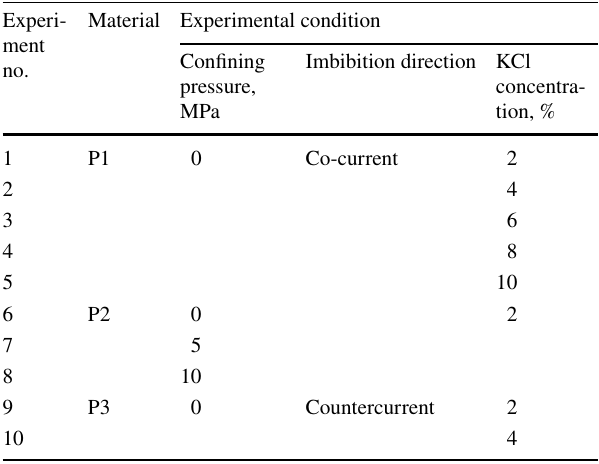
Table 4 Surface hardness damage experimental